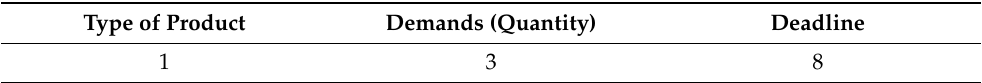
Table 2. Order Data.